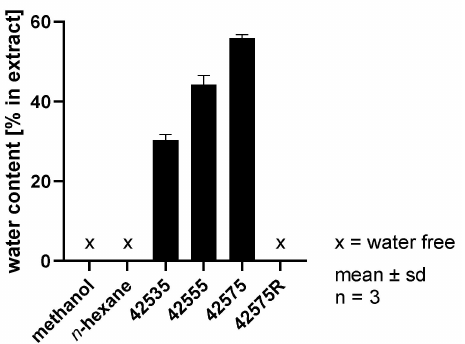
Figure 7. Water content in conventional solvent extracts with the solvents methanol and n -hexane and in scCO 2 extracts produced at 425 bar and 35 ◦ C (42535), 55 ◦ C (42555), 75 ◦ C (42575), and 75 ◦ C dissolved in methanol with subsequent removal of solvent (42575R); determined using Karl Fischer semi-micro water